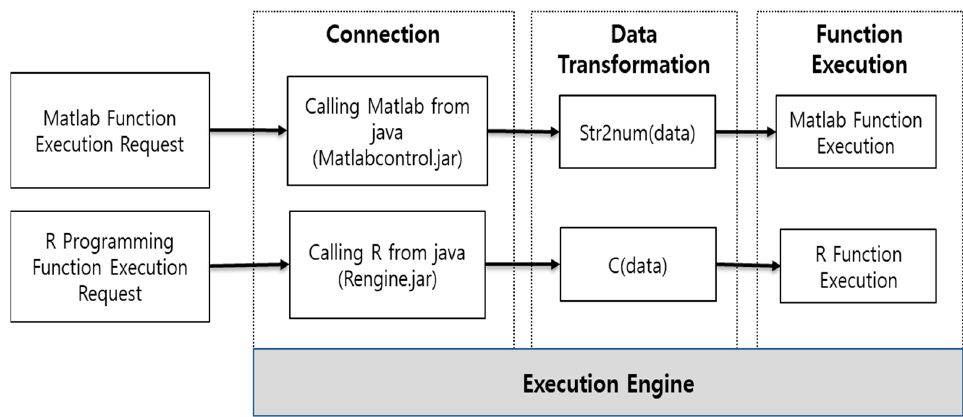
Figure 8. The architecture of functions developed in MATLAB and R programming through